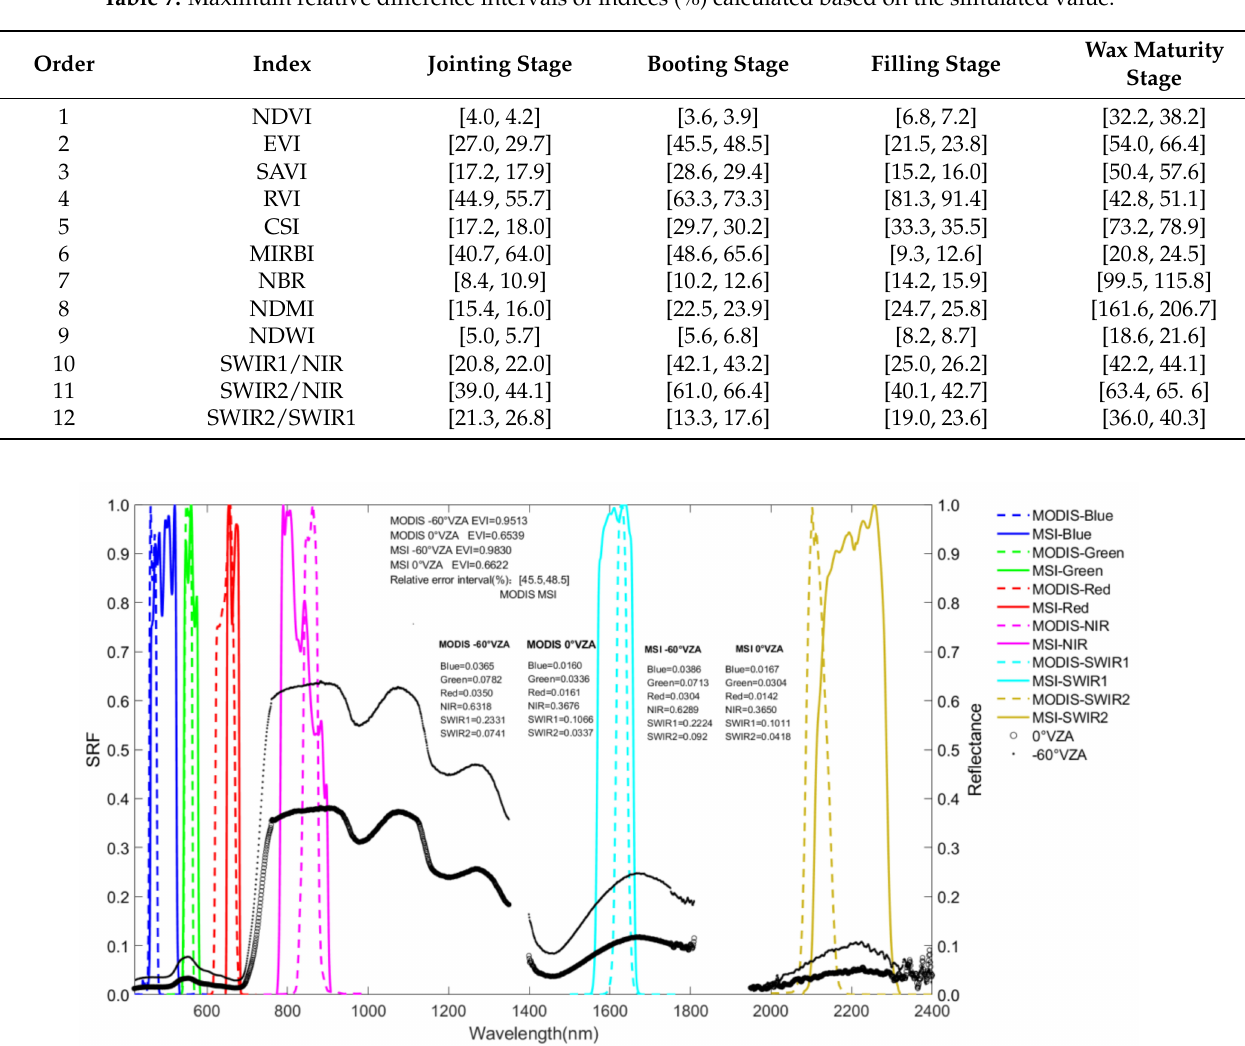
Figure 11. Illustration of the angle effect relative difference through a case of EVI calculated using from the simulated multiple sensor-like spectrum that have been simulated from ground hyperspectral reflectance collected on 3 May at nadir (empty circle) and − 60 ◦ (small solid point) VZA in the principle plane, and SRF of MODIS (dotted line) and MSI (solid